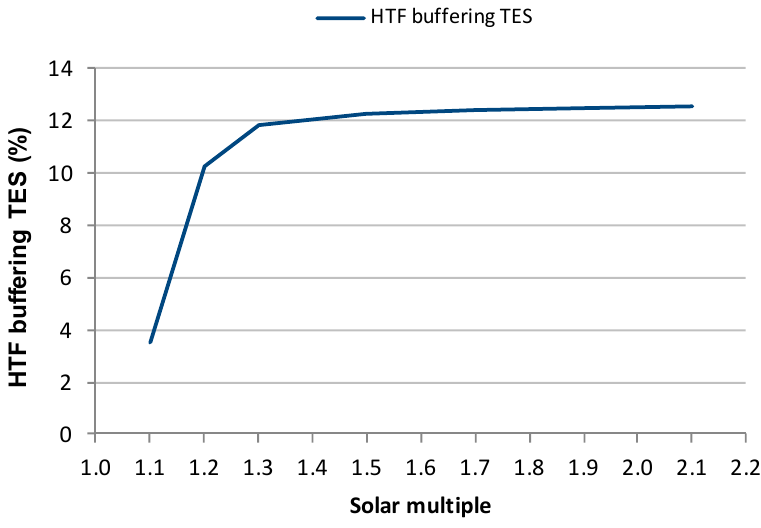
Figure 9. HTF buffering thermal energy storage by solar multiple value.